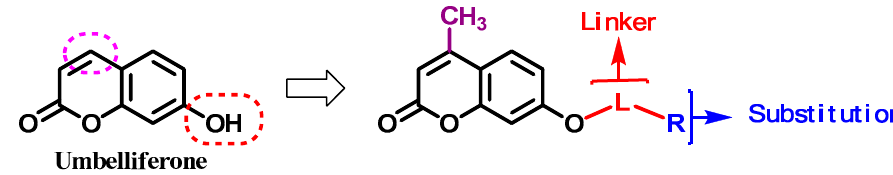
Figure 1. Umbelliferone and its potential modification sites.